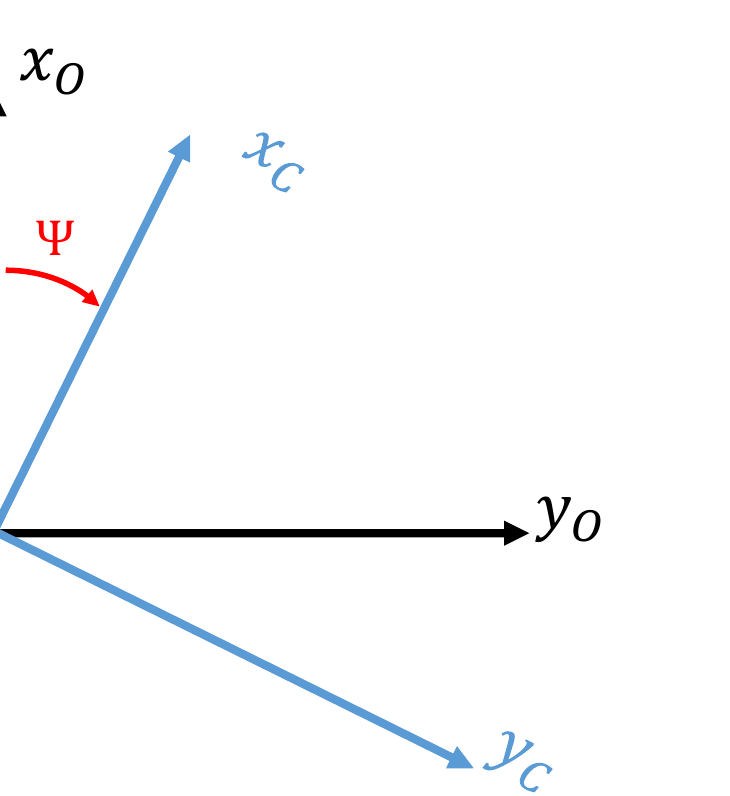
Figure 2. Visualization of the Control frame C, which is a North–East–Down frame O, rotated by the heading Ψ around the